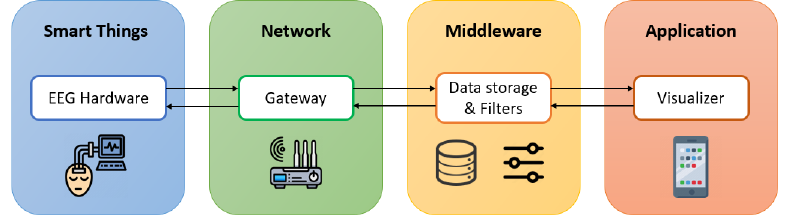
Figure 1. Proposed EEG system architecture.